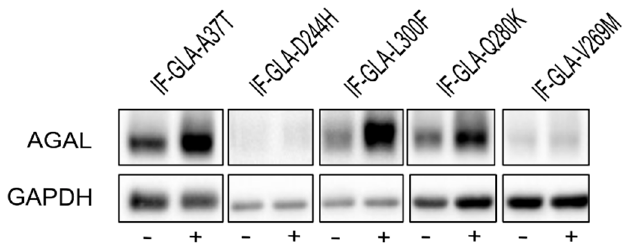
Figure 4. Combined treatment with DGJ and curcumin treatment increased AGAL. IF-GLA and IF-GLA-MUTs were treated for 48 h with 10 µ M DGJ in the presence or absence of 20 µ M curcumin. AGAL was visualized via immunoblotting on cell protein extracts. The figure shows IF-GLA-MUTs treated with 10 μ M DGJ in the presence (+) or the absence ( − ) of 20 μ M curcumin.